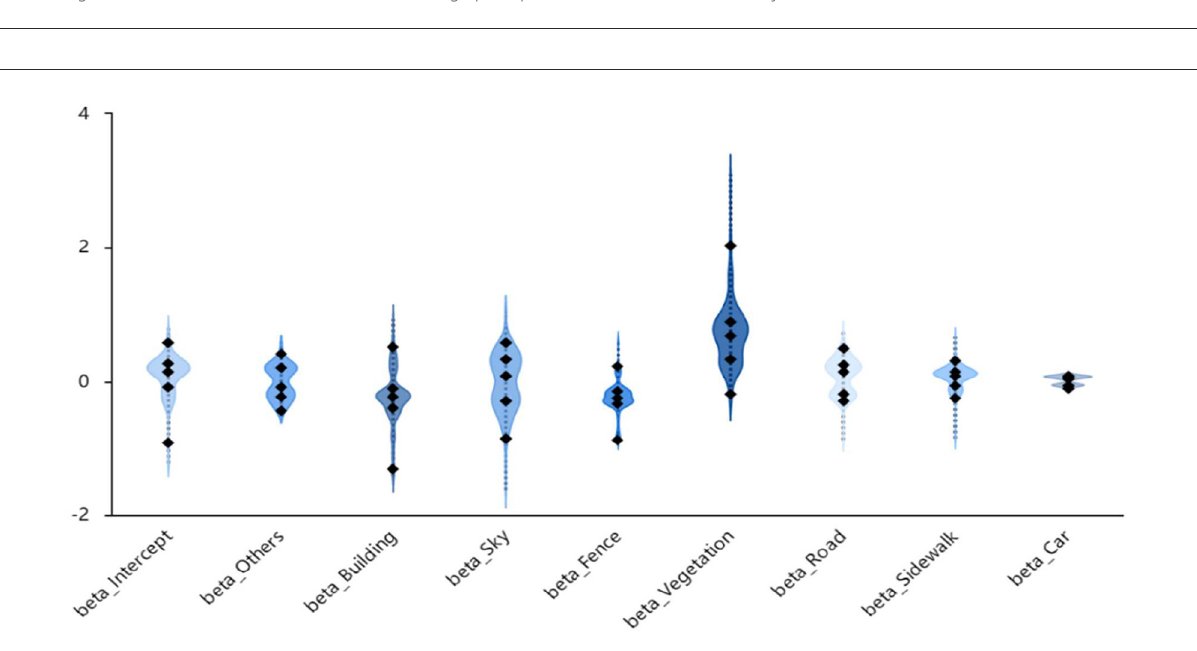
FIGURE7 Violin plot of MGWR model regression coefficient